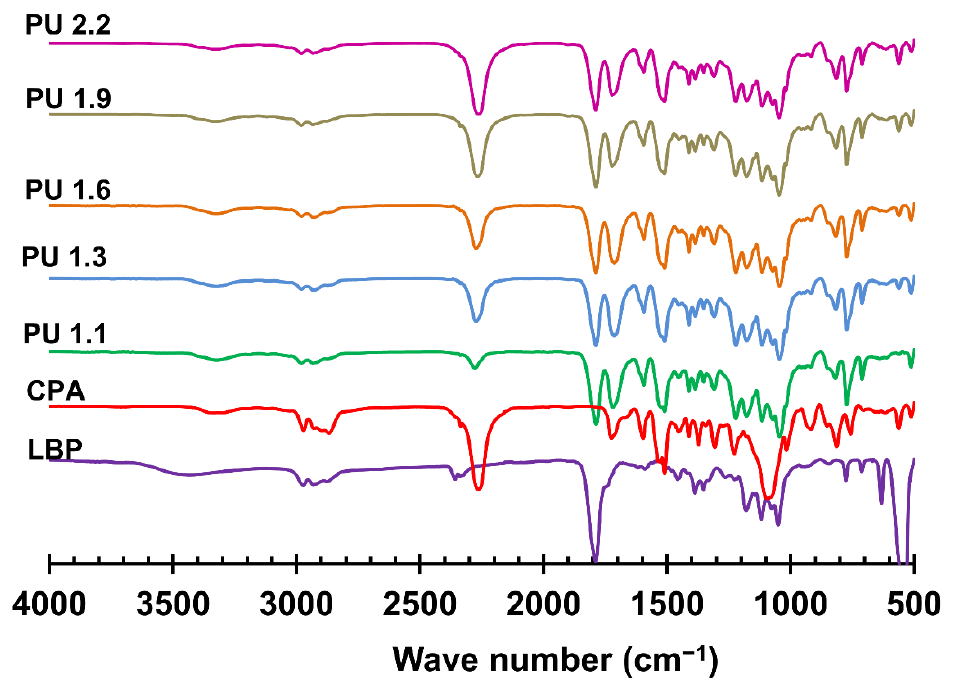
Figure 2. Normalized FTIR spectra of crude LBP, CPA, and lignin − based PU adhesives with different NCO/OH ratios (PU 1.1,1.3, 1.6, and 2.2).